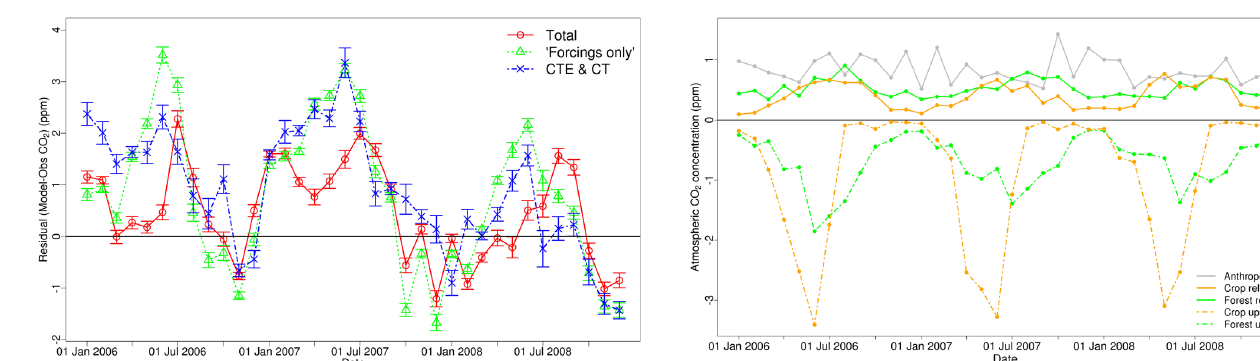
Fig. 3. Time series of monthly mean residual (Model-Obs) between observed, CTE-CT and WRF-SPA simulated total atmospheric CO 2 and “forcings only” concentrations. Highlights time periods during which the inclusion of the simulated biosphere results in a reduction in monthly mean bias. Error bars are ± 1 standard error, accounting for temporal and spatial uncertainty only.